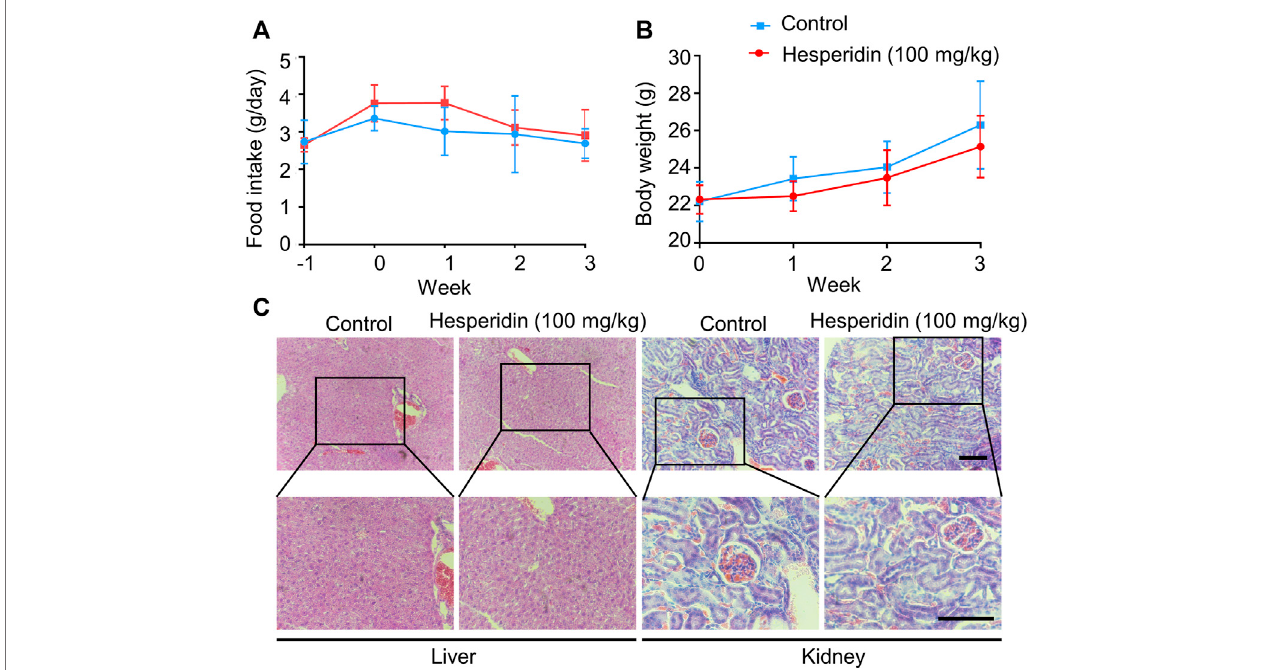
FIGURE6| Safetyofhesperidininthetreatmentoflungcancer. (A) .Foodintake. (B) Bodyweight. (C) RepresentativeofliverandkidneyHandEstaining.Scalebar = 200 μ M.